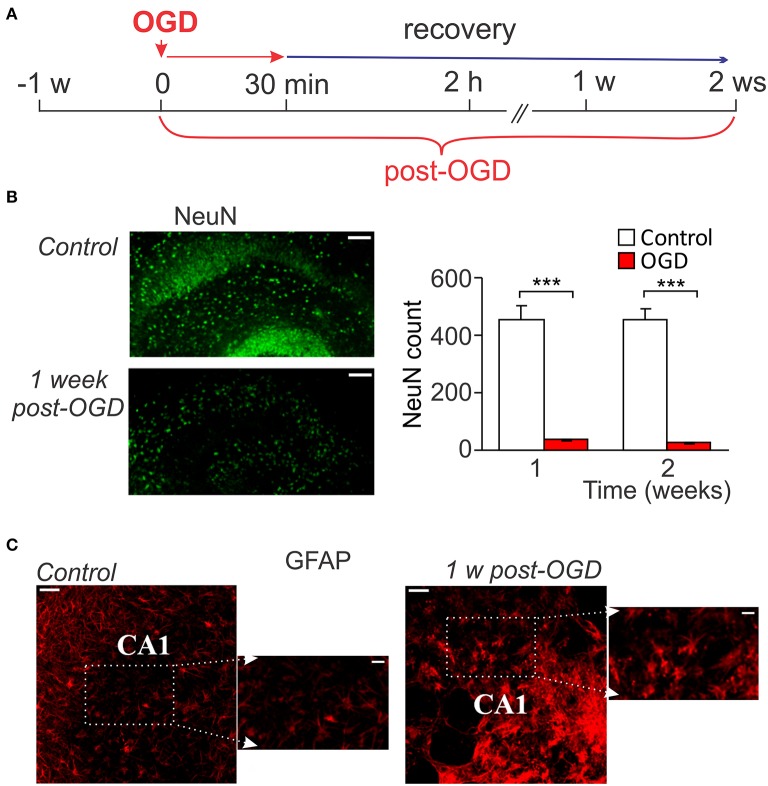
Neuronal death and astrogliosis following prolonged OGD. (A) Cartoon of an experimental modeling of prolonged ischemic conditions (30-min duration) in organotypic hippocampal slice cultures for long-term assessment of ischemic CA1 neuronal death. (B) Immunohistology with the neuronal marker, NeuN (left images), and its quantitative analysis in CA1 area in control (n = 7 slices) and after prolonged OGD (n = 3 slices exposed to 30-min OGD; right graphs). Scale bar, 100 μm. Data are mean with s.e.m. ***P < 0.001 (t-test). (C) Immunohistology with astrocytic marker GFAP in control organotypic slice and one exposed to prolonged OGD 1 week-post. Note a prominent outgrowth of GFAP-positive cells after OGD. Scale bar, 50 μm; insert, 20 μm.